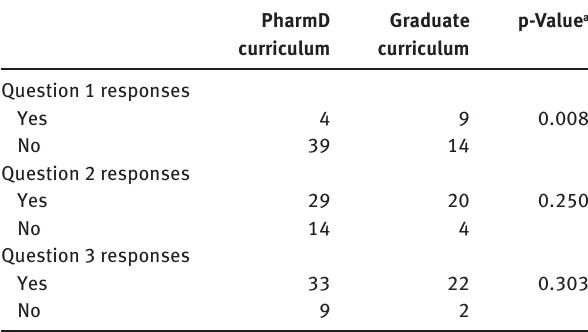
Table 2 Contingency tables comparing the responses for PharmD with graduate student